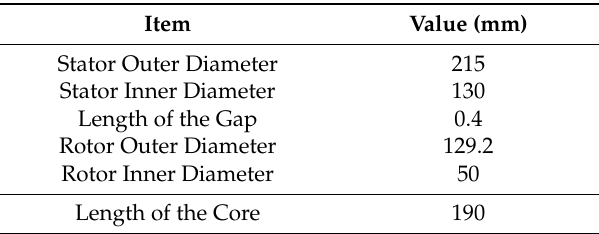
Figure 11. Stator, rotor structures, and test platform of the prototype. Table 1. The parameters of the brushless doubly-fed machine.